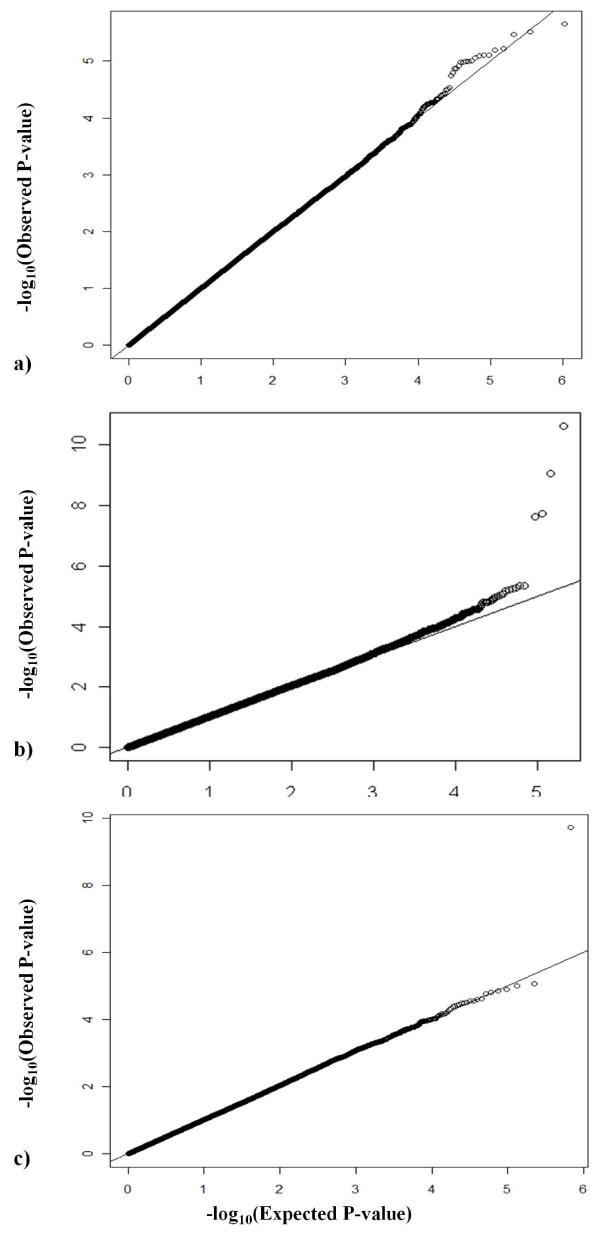
Quantile-Quantile plots for test statistics for SNPs passing quality control in each dataset. Figure shows -log10 (p-value) of observed association statistics in Y-axis, compared to -log10 (p-value) of the association statistics expected under the null hypothesis of no association in X-axis. The solid line represents concordance of observed and expected values. The genomic inflation factor, λ, is shown for each dataset. A) Ashkenazi Jewish (λ = 1.003), b) NINDS (λ = 1.026), and c) CIDR/Pankratz et al 2009(λ = 1.031).